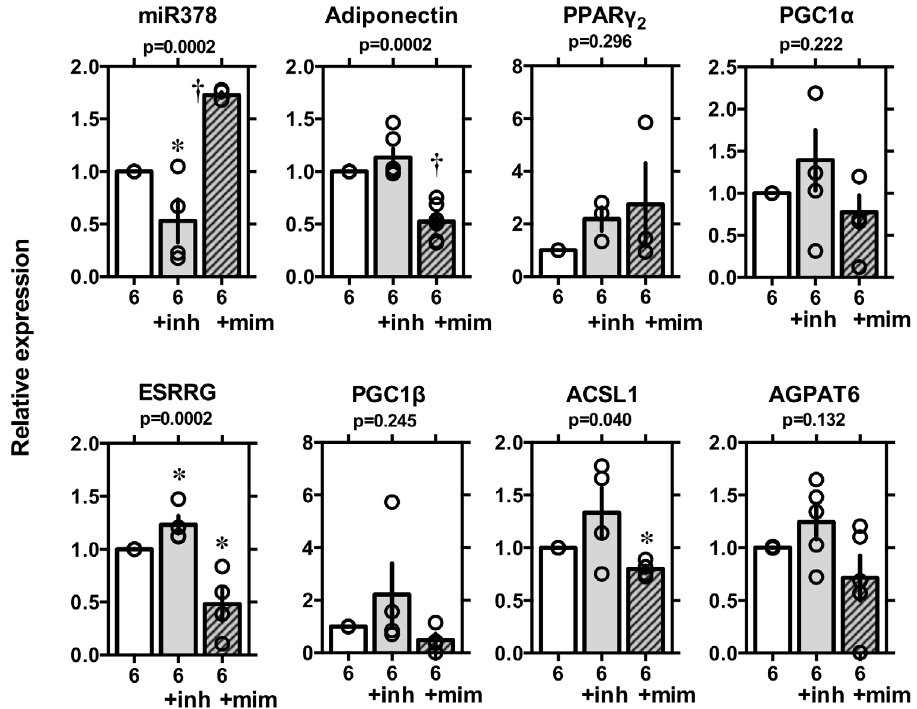
Figure 3. Levels of miRNA-378, adiponectin, PPAR c 2 , PGC1 a , ESRRG, PGC1 b , ACSL1 and AGPAT6 in 3T3-L1 adipocytes overexpressing the inhibitor (inh) or mimic (mim) of miRNA-378. The mouse 3T3-L1 cell line was cultured in DMEM/10%FBS and dispensed into 12-well plates (day 2) before induction of adipose differentiation. Once the cells had grown confluently, they were stimulated with 1.7 mM insulin (10 m g/mL), dexamethasone (1 nM), and IBMX (500 m M) for 2 days (days 0–2) and the medium was changed every 2 days. On day 4, overexpression and knockdown of miRNA-378 were done by transfecting the miRNA-378 mimic and/or inhibitor. On day 6, levels of miRNA-378 and mRNA levels of adiponectin, PPAR c 2 , PGC1 a , ESRRG, PGC1 b , ACSL1, and AGPAT6 were evaluated by qPCR. Expression levels normalized to those of b - actin were log-transformed. Individual values are shown with mean 6 SE (n=6). p values are shown for multigroup comparison by non-parametric Kruskal-Wallis test. *p , 0.05 and { p , 0.01 vs . day 6 for unpaired two group comparison by Wilcoxon-Mann-Whitney